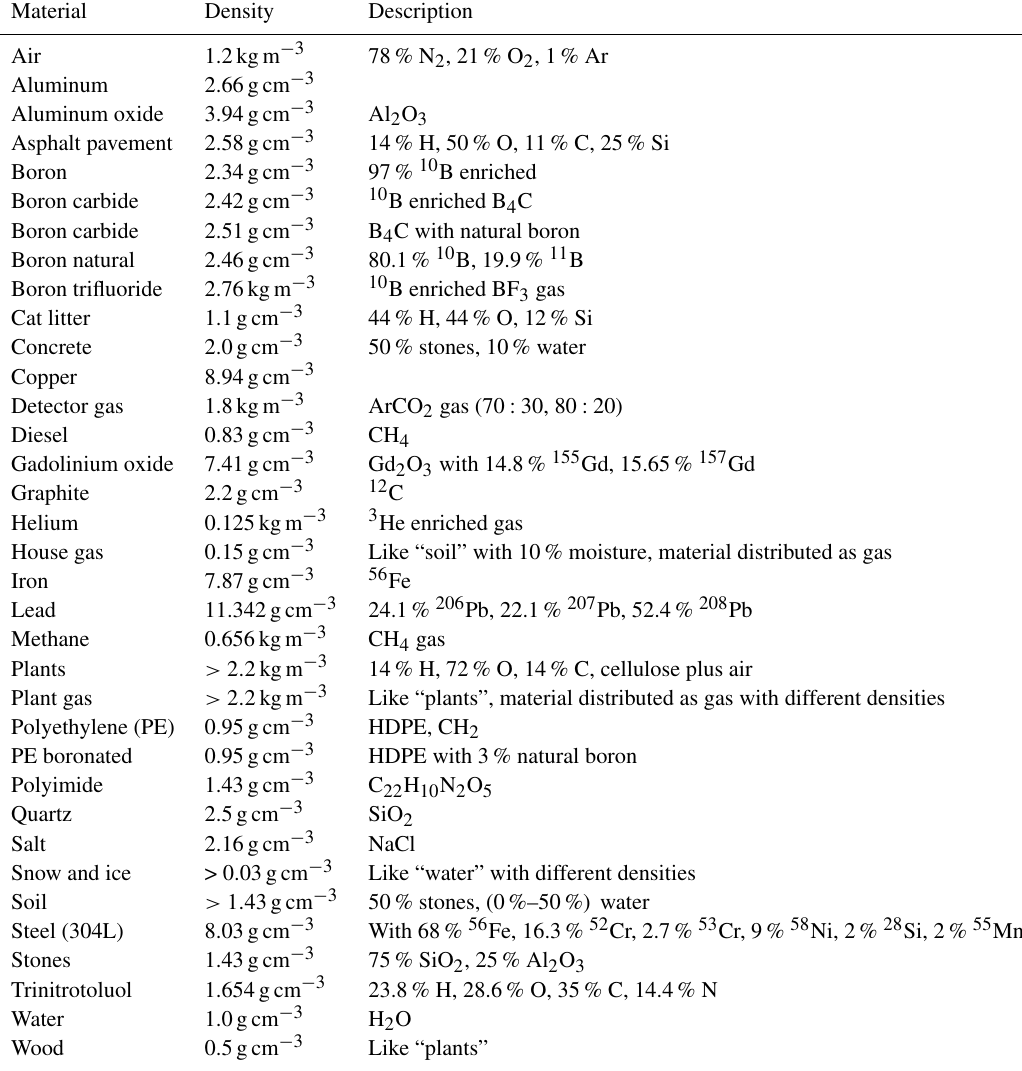
Table B1. List of preconfigured materials available in URANOS with their composition and density.